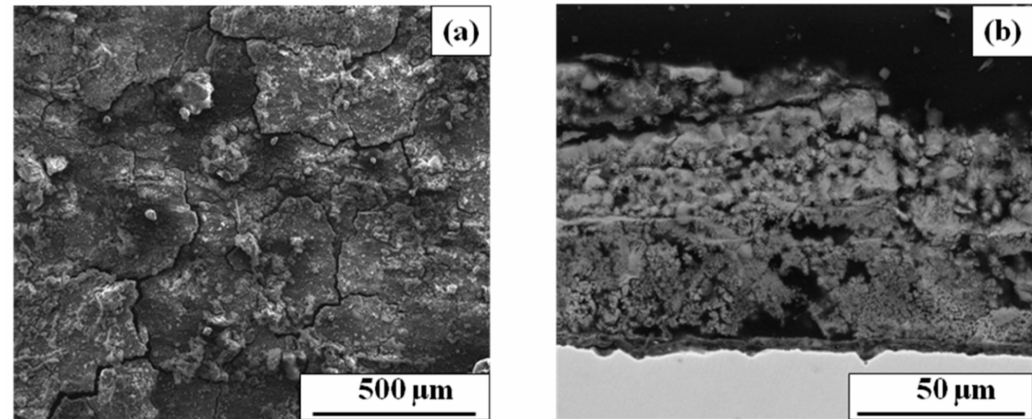
Figure 10. The surface ( a ) and cross-sectional ( b ) morphology of the samples with 50 g/L phosphoric acid mixed in the tannic rust converter application (adjusting the pH value to 2.58 by